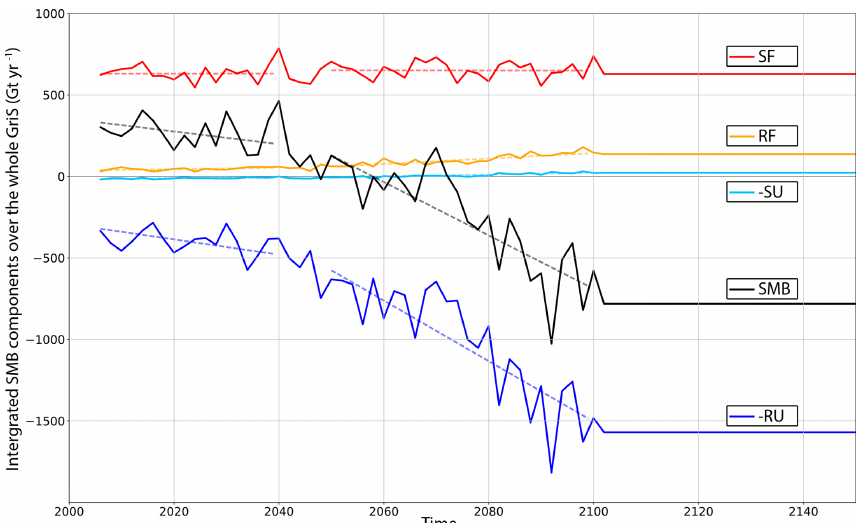
Figure 1. Evolution of the SMB (black line) and its components from 2005 to 2150 (in mGtyr − 1 ) simulated by MAR in the 2W experiment and integrated over the ice sheet mask taken from Bamber et al. (2013). The SMB components are snowfall (SF, red line), rainfall (RF, orange line), sublimation (-SU, light blue line) and runoff (-RU, dark blue line). Dashed lines correspond to regression lines ranging from 2000 to 2039 and from 2041 to 2099. The solid grey line corresponds to the zero line.